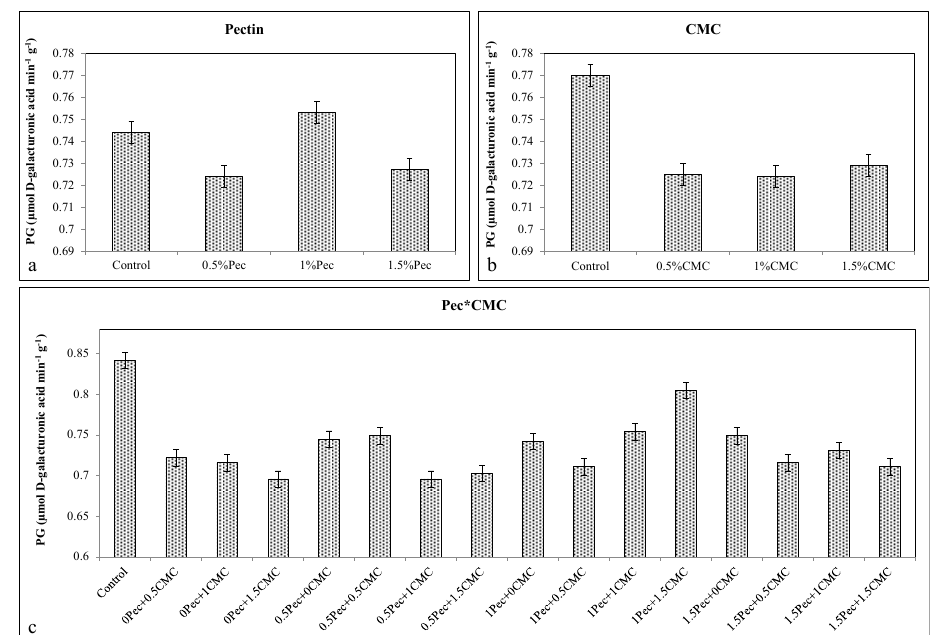
Figure 12. Effect of 0 (control), 0.5 (0.5% Pec), 1 (1% Pec) and 1.5 (1.5% Pec) % pectin-based edible coatings ( a ), 0 (control), 0.5 (0.5% CMC), 1 (1% CMC) and 1.5 (1.5% CMC) % carboxymethylcellulose-based edible coatings ( b ) and their combinations ( c ) on polygalacturonase (PG) enzyme activity during cold storage period. Data are the “estimated marginal means ±95% confidence intervals”. The results were expressed on a fresh weight basis. The columns with non-overlapping error bars are significantly different ( p ≤ 0.05).